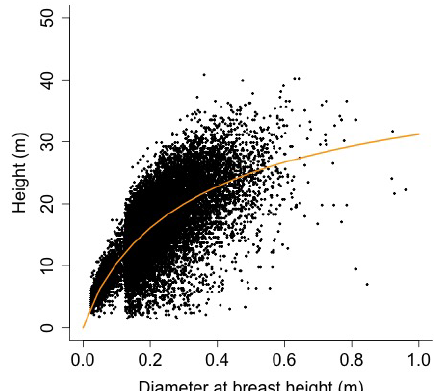
Figure D13. Height model fit to FIA data for Robinia